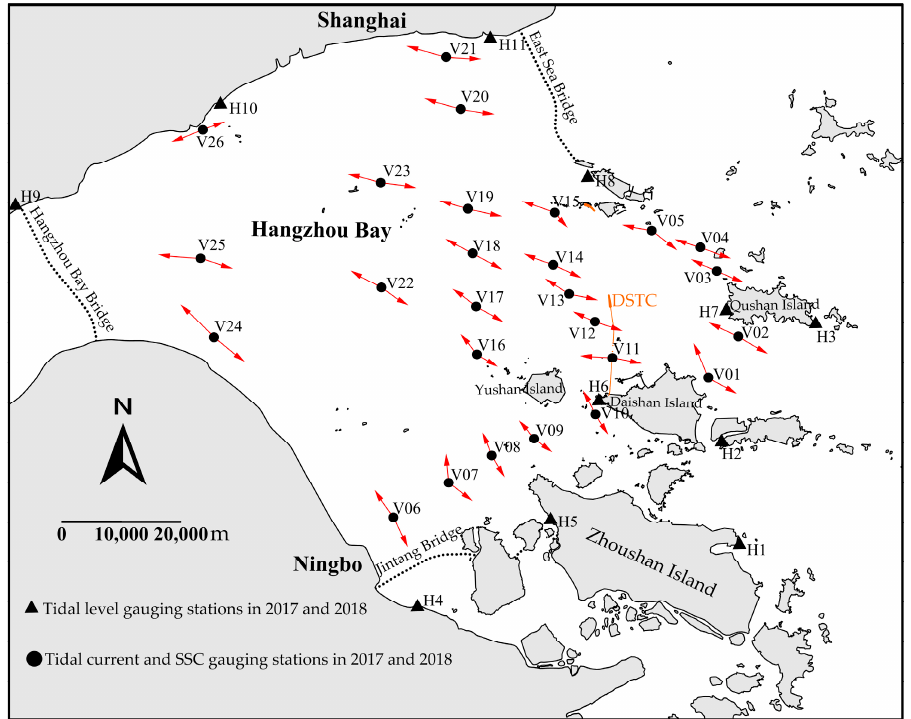
Figure 3. Indication of the main tidal current directions and locations of measurement stations. H1– H11 are the tidal level gauging stations, V1–V26 are the tidal current and suspended sediment con- centration gauging stations).